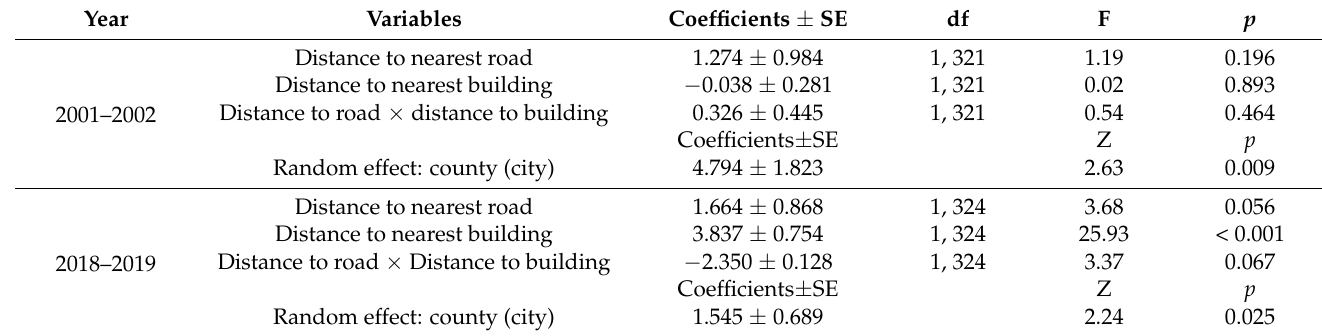
Table 1. Analysis of the effects of roads and buildings on the Reeves’s pheasant distribution using generalized linear mixed models.